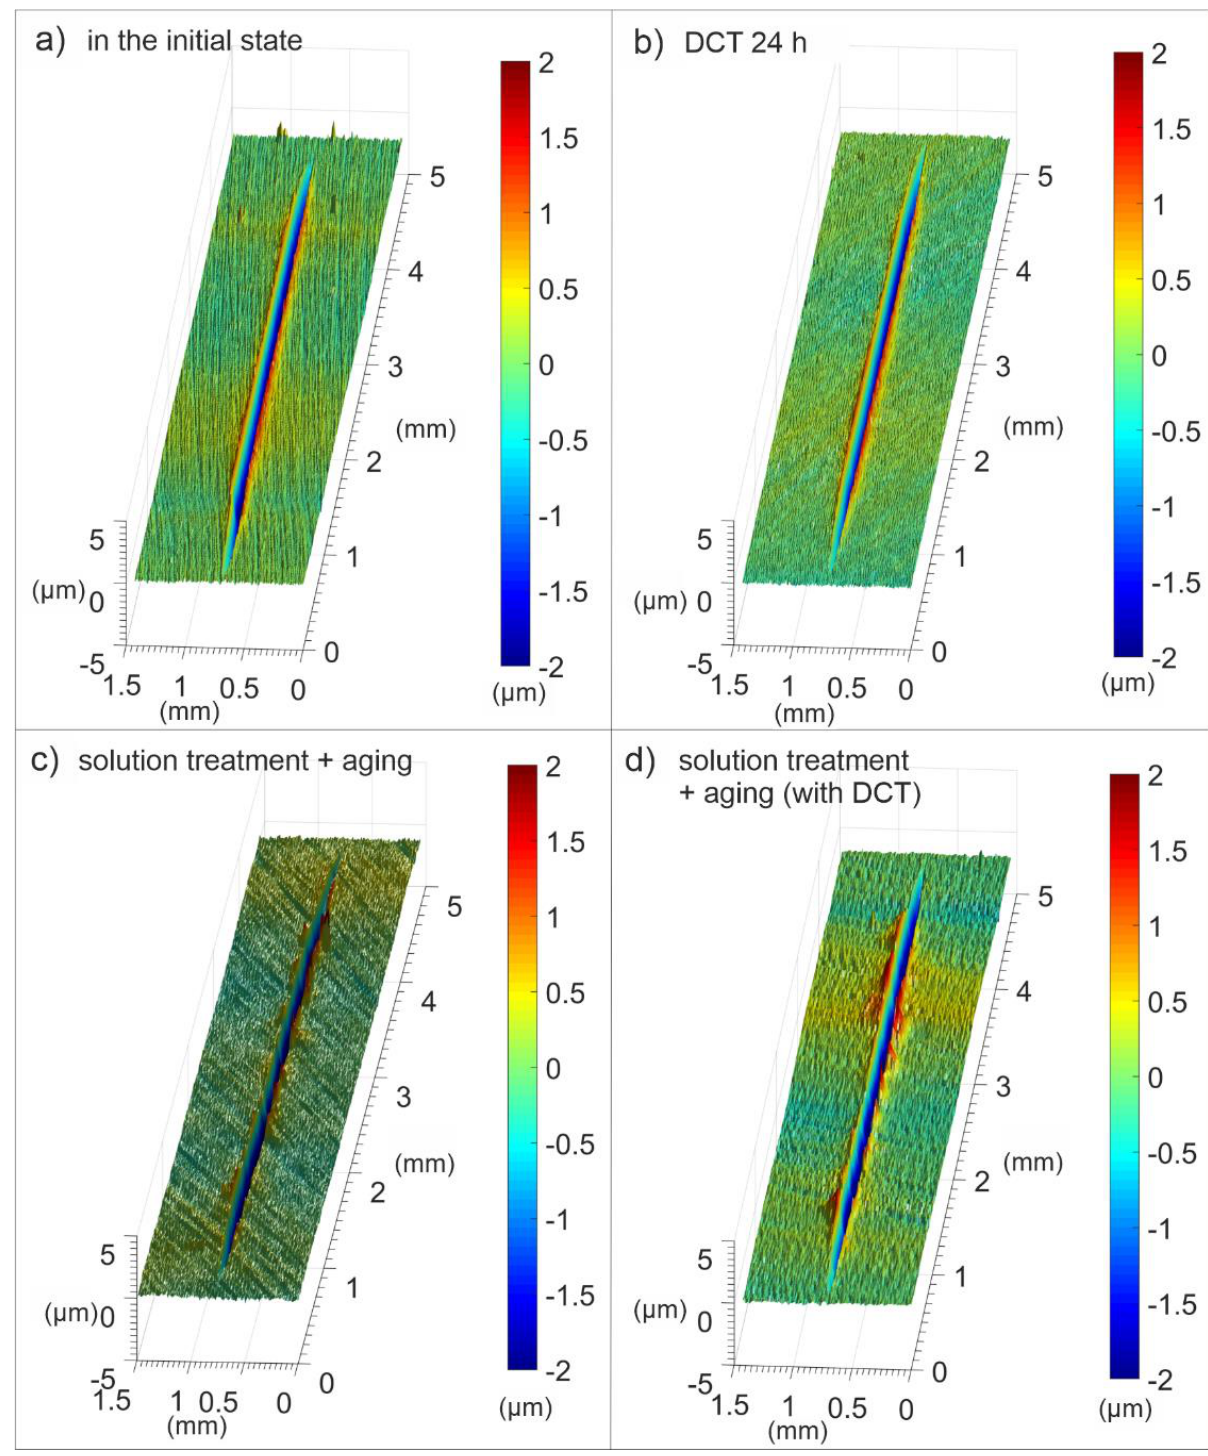
Figure 9. Isometric images (3D) of scratch wear tracks of the Mg-Y-Nd alloy in the initial state and after different heat treatment variants: in initial state ( a ) and after deep cryogenic treatment ( b ), solution treatment + aging ( c ), solution treatment + aging + DCT ( d ).